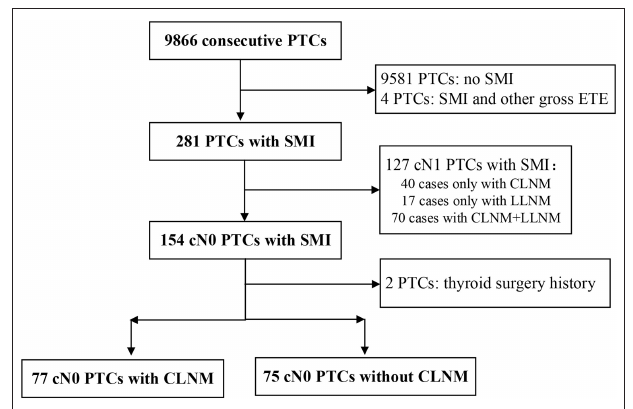
FIGURE 1 | Flowchart of patient